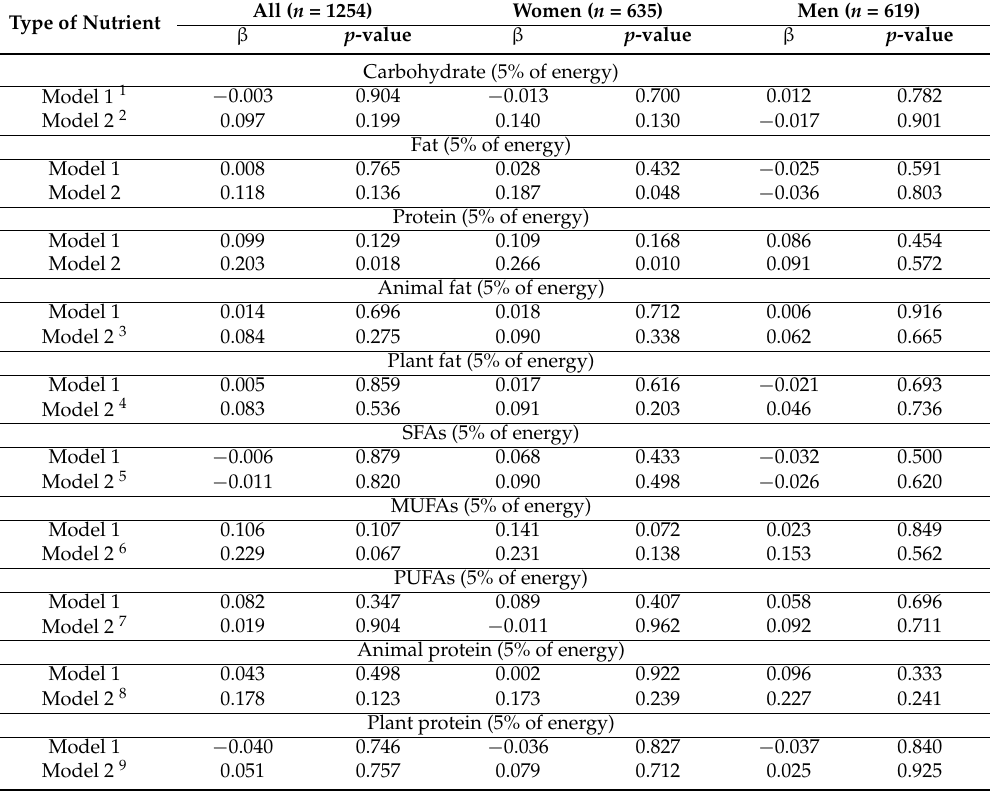
Table 2. Estimated effects of nutrient intakes on 3-year visceral adiposity index